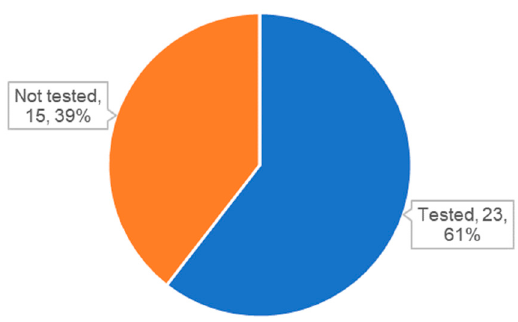
Figure 4. Status of analysis for specific markers for exosomes or extracellular vesicles (EVs).